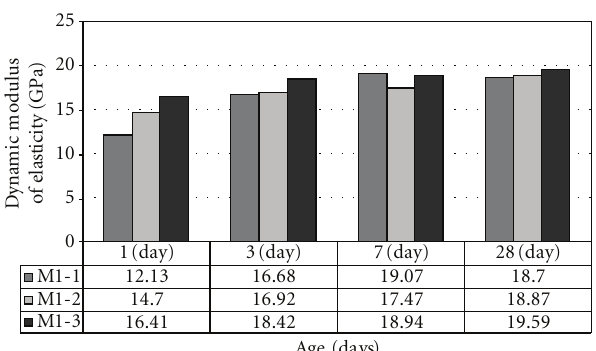
Figure 3: The dynamic modulus of elasticity for the 1st group of